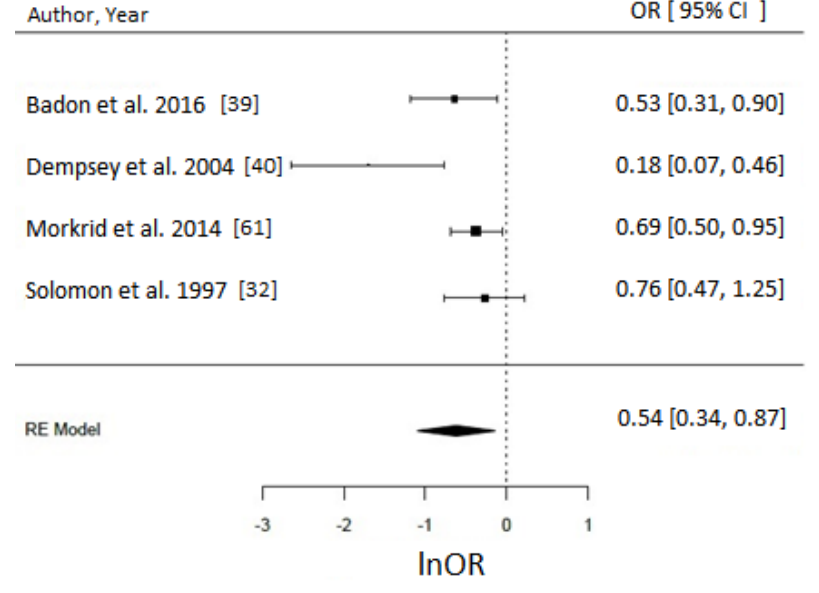
Figure 5. Metaanalysis of participation in high versus low level of leisure time physical activity (LTPA) before pregnancy in metabolic equivalents (MET.hr/week) and odds of gestational diabetes (GDM). Estimates are expressed as odds ratios (OR) with their corresponding 95% confidence intervals, however x -axis uses lnOR scale. Taking part in ~>15 MET.hr/week suggested 52% reduced odds of GDM (OR = 0.52, 95% CI = 0.27–1.00; I 2 = 95%, p -value = 0.05). Due to insufficient number of studies reporting on LTPA in MET.hr/week in early pregnancy, a meta-analysis could not have been performed. Nutrients 2018 , 10 , x FOR PEER REVIEW